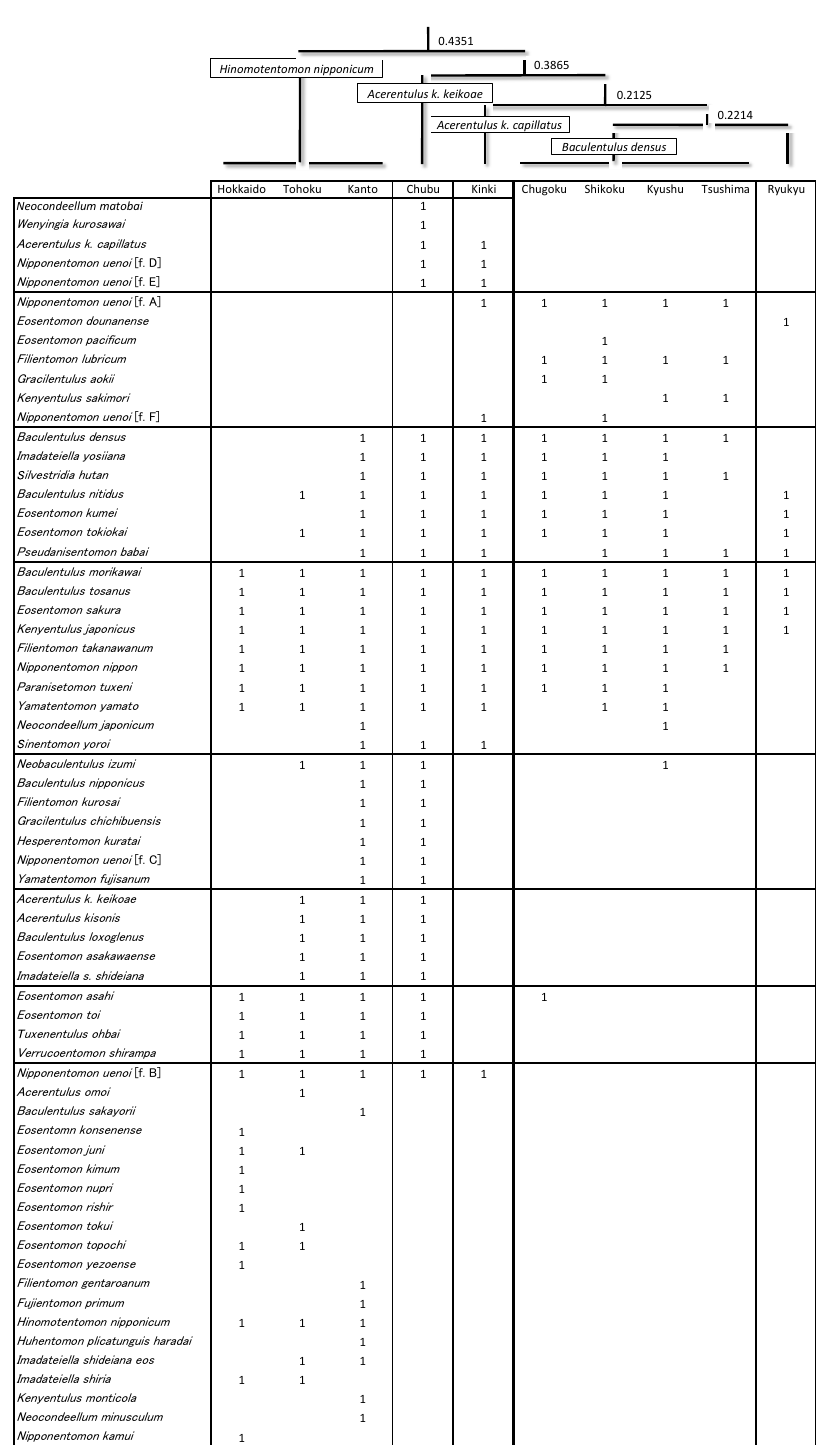
Figure 3. Regional species assembly (produced by TWINSPAN) of Protura. Numbers and species names on the dendrogram represent the eigenvalue and the indicator